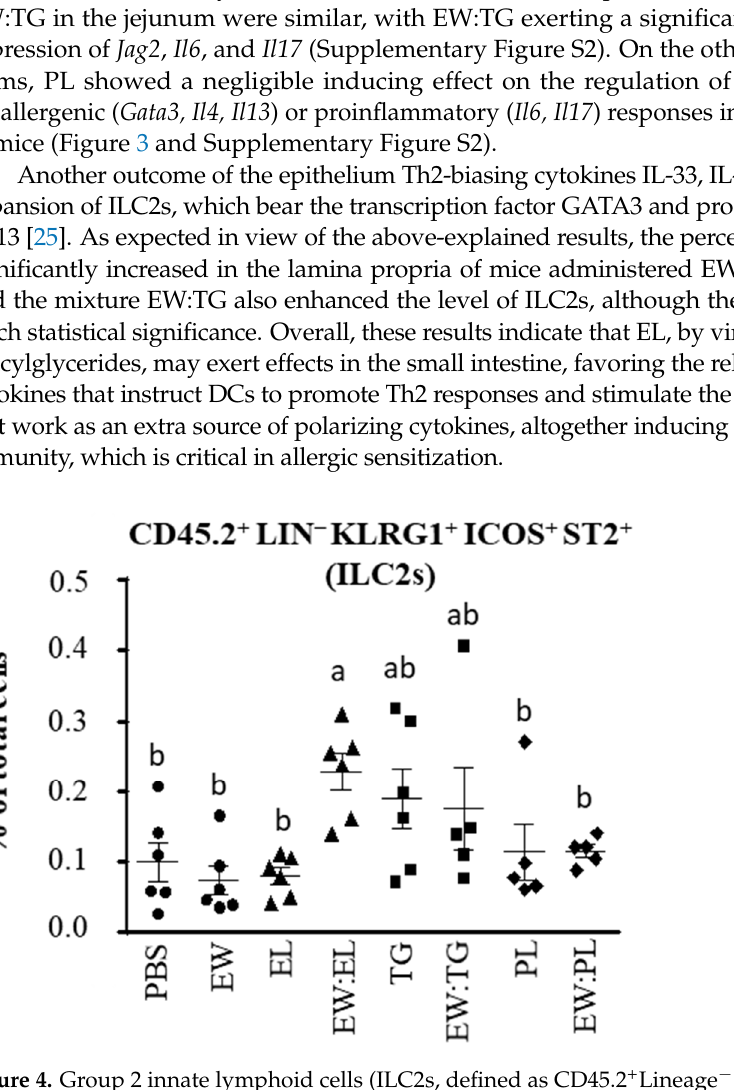
Figure 4. Group 2 innate lymphoid cells (ILC2s, defined as CD45.2 + Lineage − KLRG1 + ICOS + ST2 + ) within the total cells in the lamina propria of mice intragastrically administered PBS, egg white (EW, 50 mg), egg lipids (EL, 60 mg), a triacylglyceride-enriched fraction (60 mg, TG), a phospholipid- enriched fraction (60 mg, PL) and their mixtures (50 mg:60 mg) with EW (respectively EW:EL, EW:TG, EW:PL) for 6 consecutive days. Data are expressed as means ± SEM ( n = 6). Different letters indicate statistically significant differences ( p < 0.05) among different mouse groups.